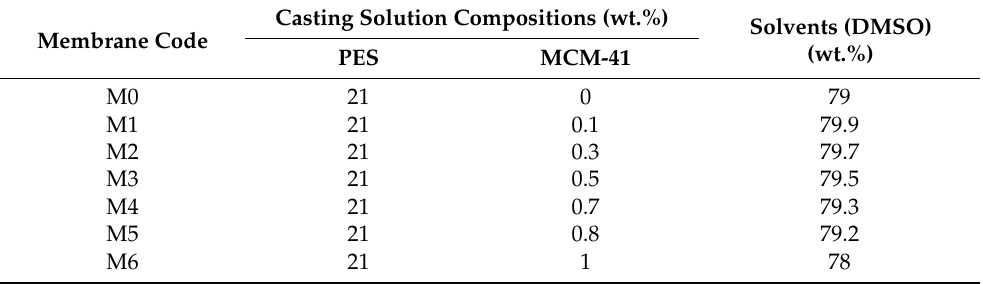
Table 1. Compositions of PES/MCM-41 casting